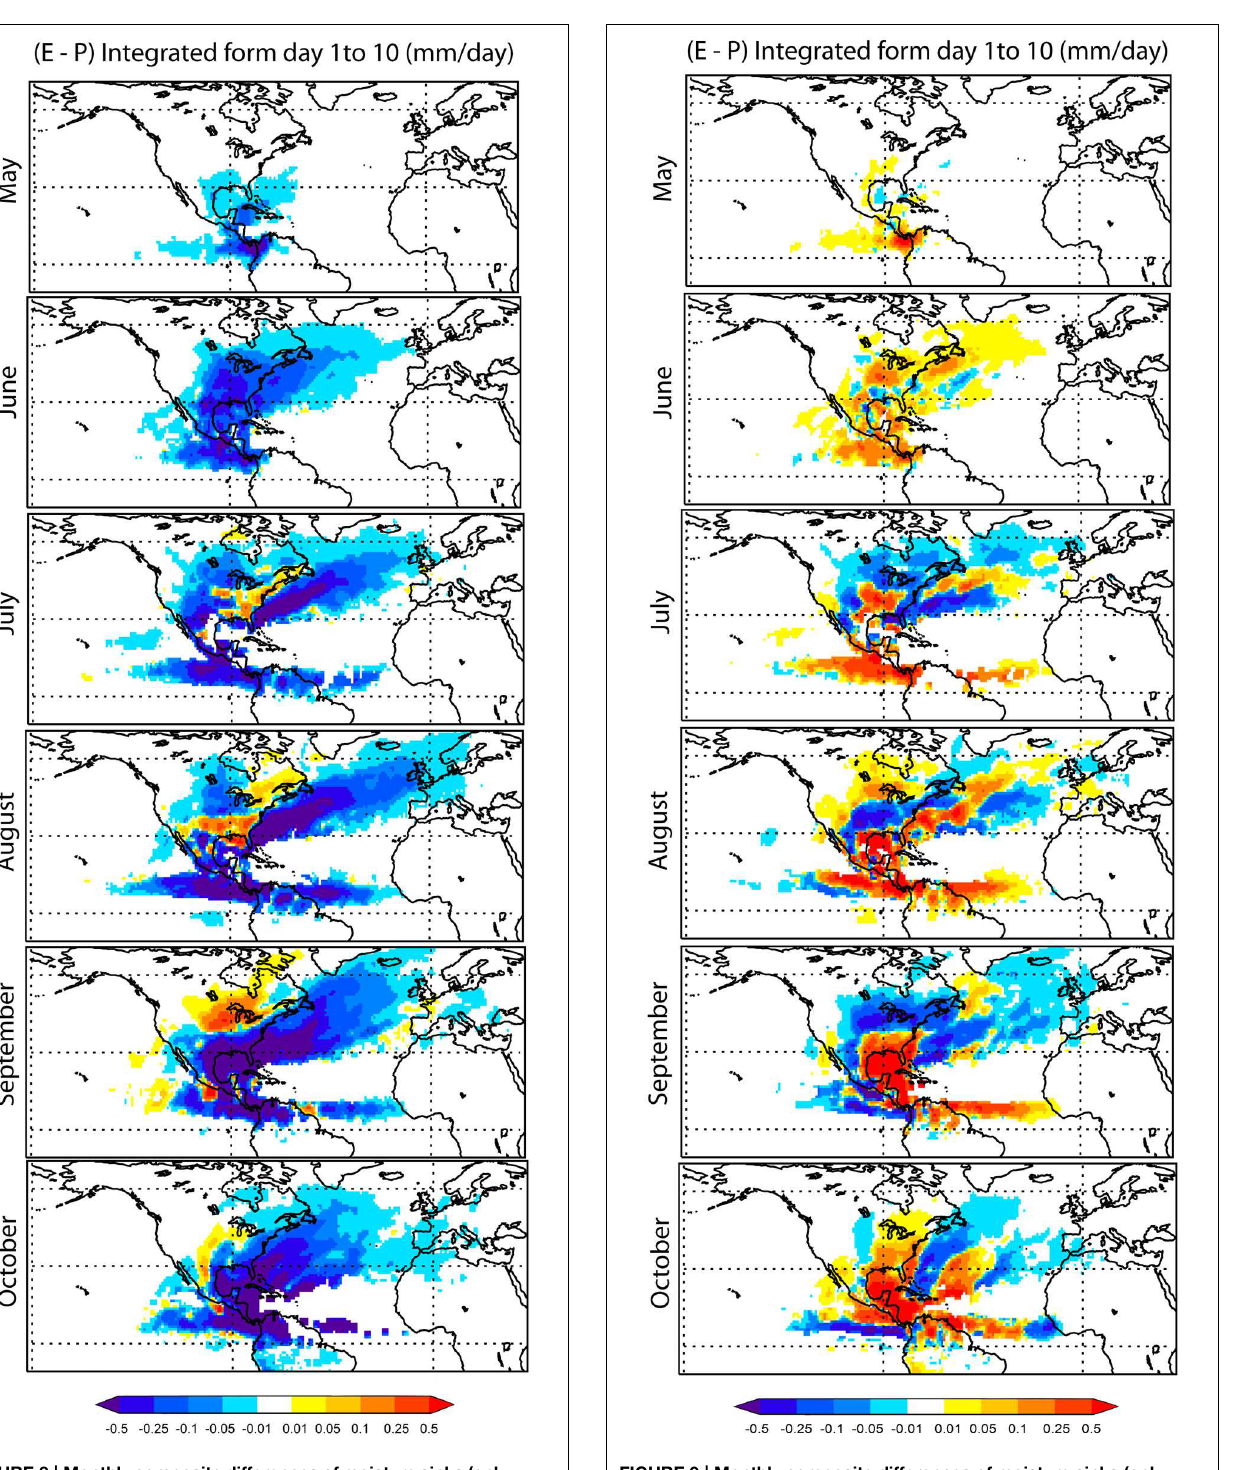
FIGURE 8 | Monthly composite differences of moisture sinks (only E − P < 0 values)betweenyearswiththelargestandsmallestAWPareas during the period 1982–1999 (Tables 2, 3, respectively). Units are mm d − 1 .